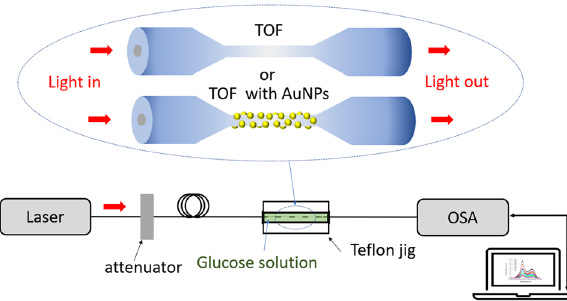
Figure 1. Experimental setup for glucose